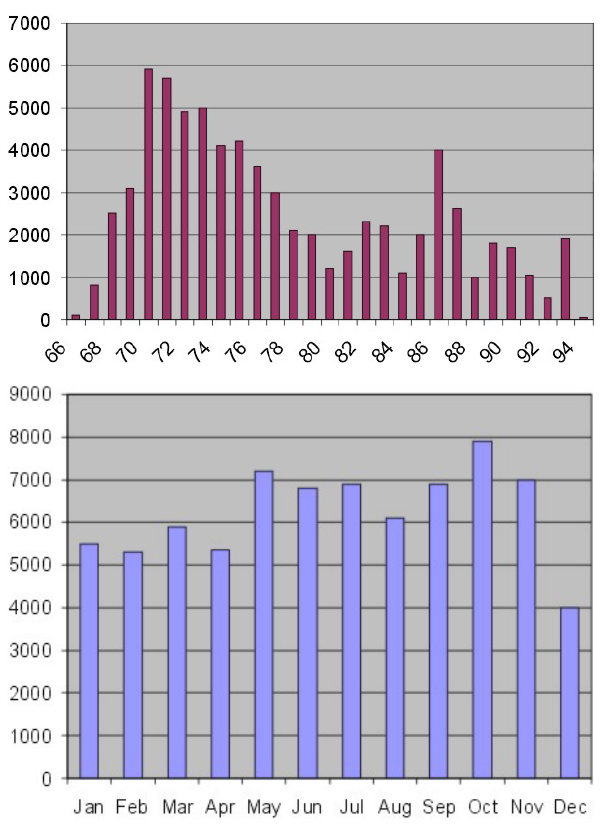
Fig. 3. Annual (a) and monthly (b) distribution of XBT data from